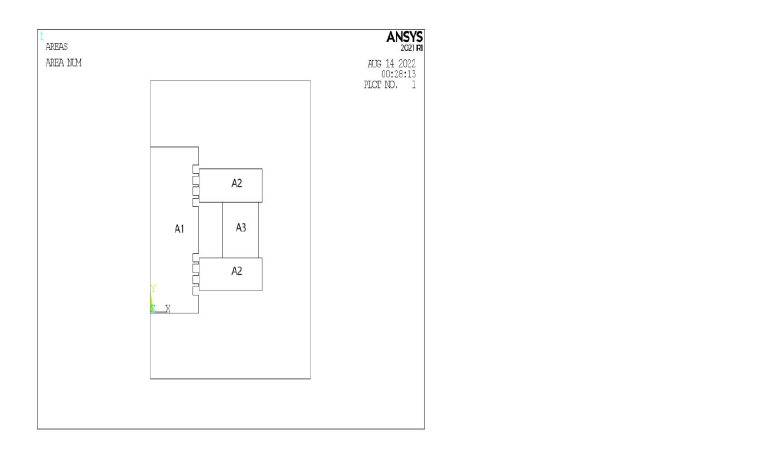
Figure 9. Simulation model of the magnetic field of the magnetic fluid seal.